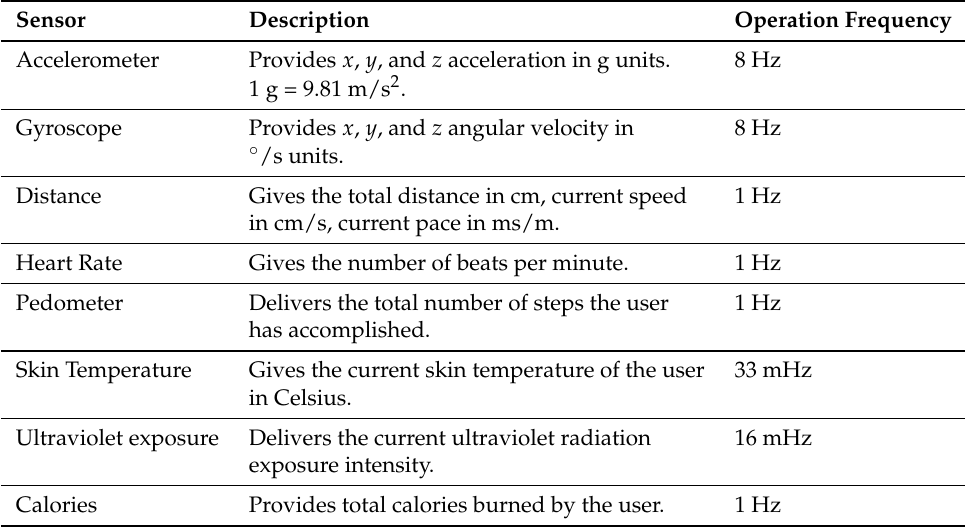
Table 1. Description of sensors in the